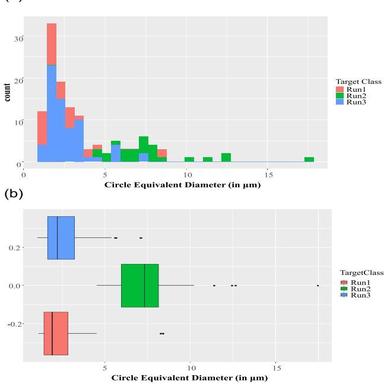
(A) Histograms to visualize the Cluster Size of API (CE Diameter Vs. Count) in various run. (B) Box Plot visualize the cluster size distribution by CE Diameter in various run.